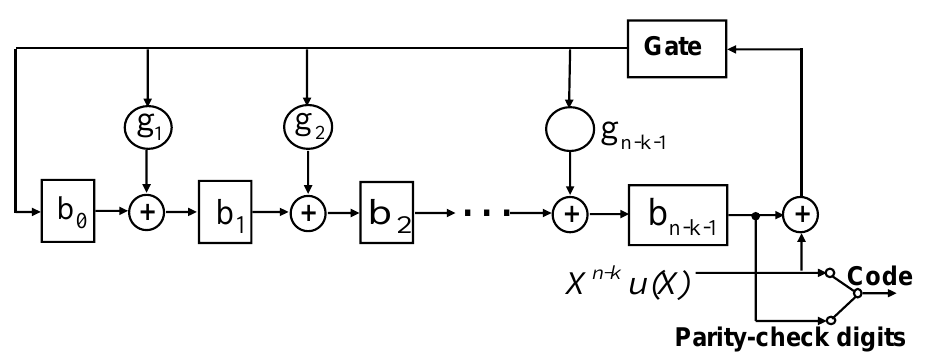
Figure 8. Architecture of ECC